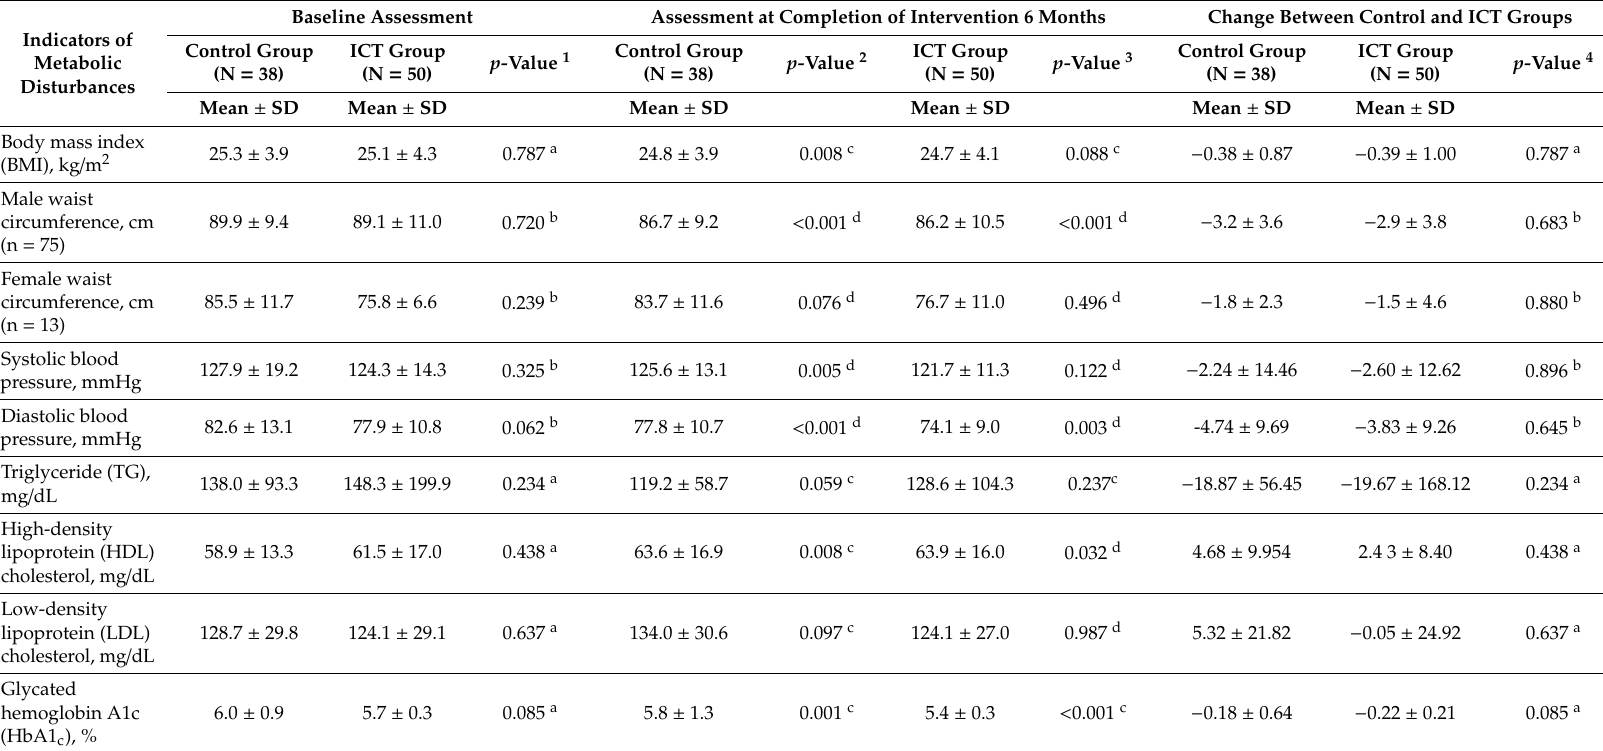
Table 1. Comparing the ICT and control groups at baseline and at 6